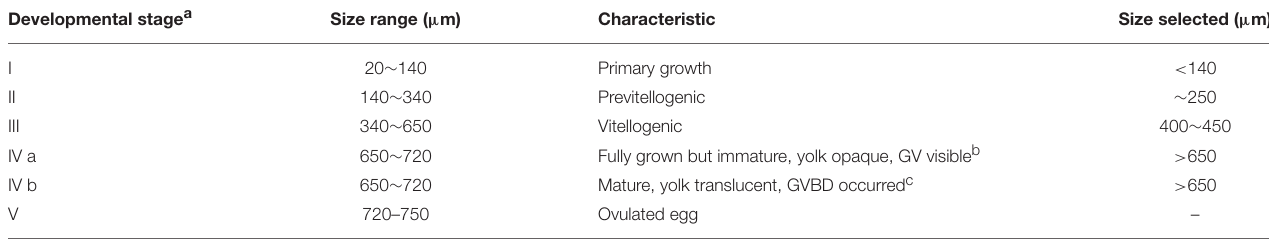
TABLE 1 | Classification of different developmental stages of zebrafish